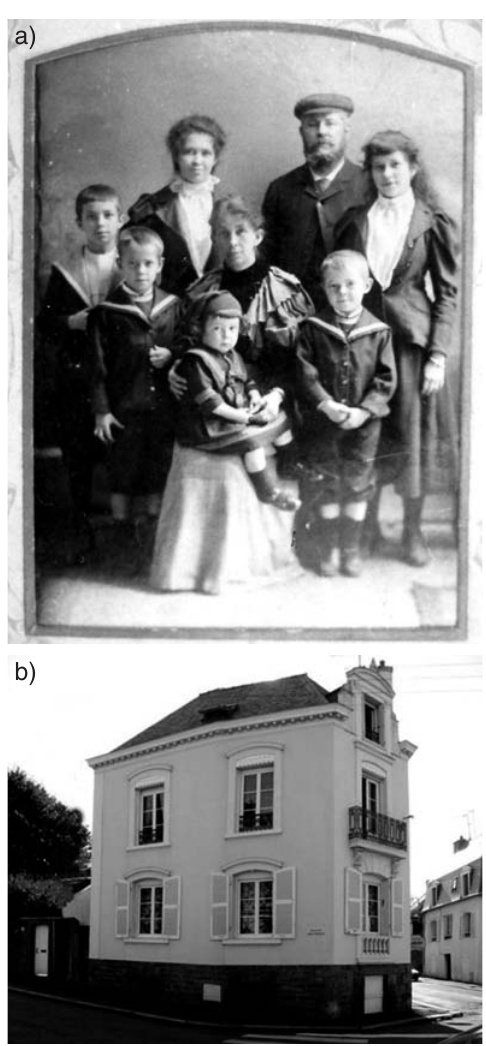
Fig. 5a,b. a) The Mantovani family. From left to right: Roberto (same name of the father, was engineer of the Paris Metro), Carlo (was professor in the Gym- nasiums), Margherita, the little Itala (dead at 15 old), Anna Piet, Roberto Mantovani, Renato (was Governor in Indochina and father of Yvane), Luigina. b) The Italian-style Villa Sivori in Saint Servan France, Bd Surcouf, where the Mantovani’s family settled. The Boulevard is now divided into rue Eugène Brouard in the north and Bd Henry-Dunant in the south. Roberto Mantovani dedicated his house to Camillo Sivori (Ge- nova 1815 - Genova 1894), a virtuoso of the violin pupil of Paganini and teacher of